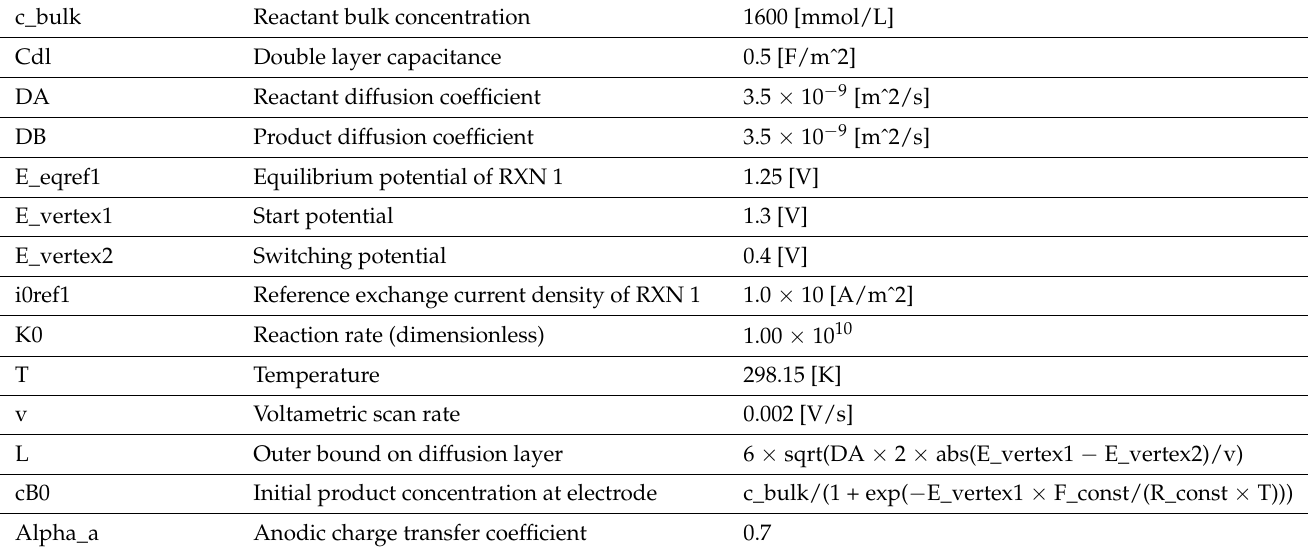
Table 2. Parameter values for linear scanning voltammetry.